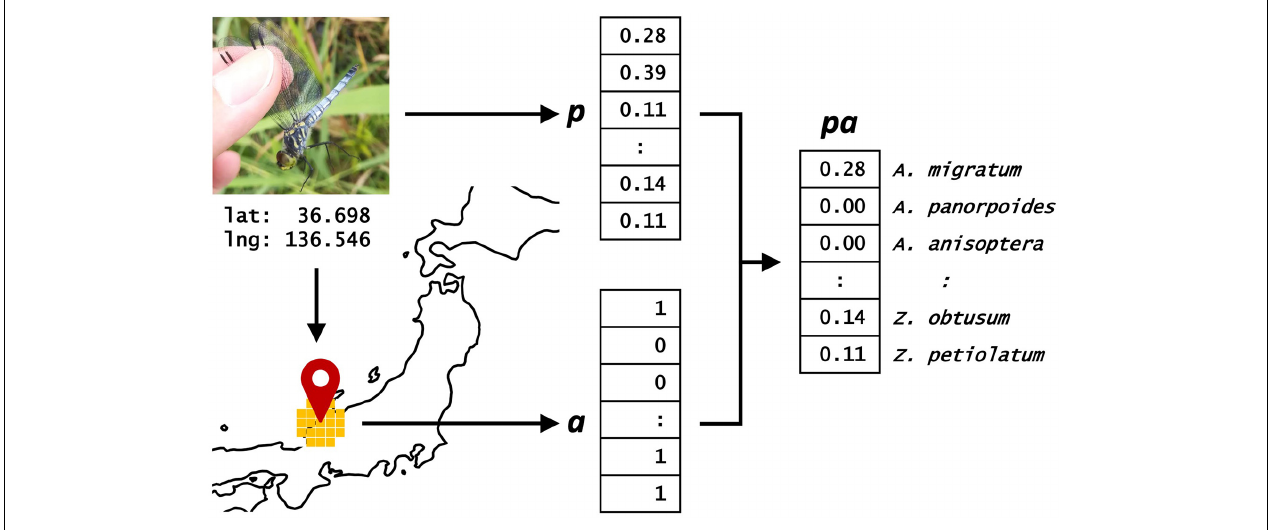
FIGURE 2 | Combined model for species identification of odonates. Scores of 204 species (p) were calculated from the image-based model. Status of appearance of 204 species ( a ) were summarized from ecological survey data. Scores of the combined model were calculated by multiplying p and a .